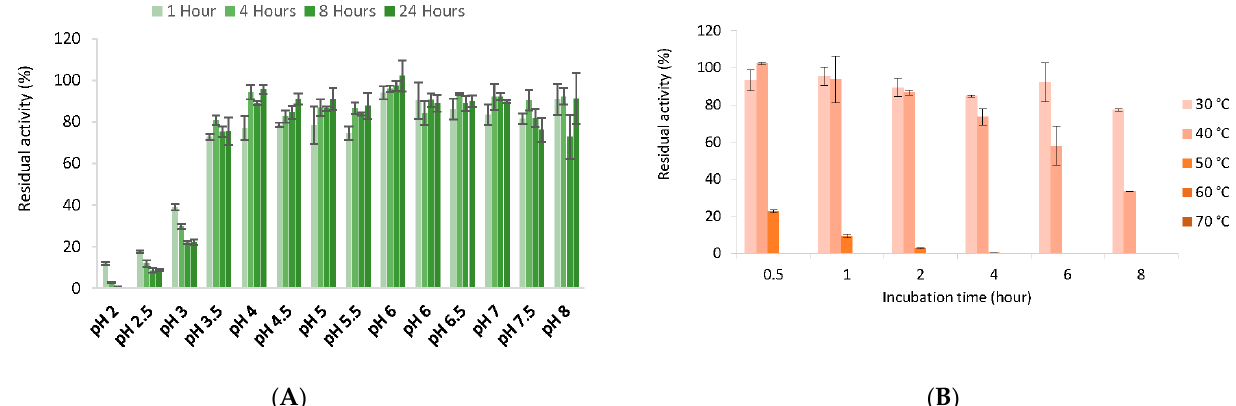
Figure 6. Enzyme stability under different pH and temperatures. ( A ) Stability after incubation for different time periods at pH 2–8; ( B ) Stability after incubation for different time periods at 30–70 °C. Measured enzymatic activity at different temperatures. Activities were calculated as a relative percentage of the activity before incubation. Mean values are reported, and standard deviations are presented by error bars.